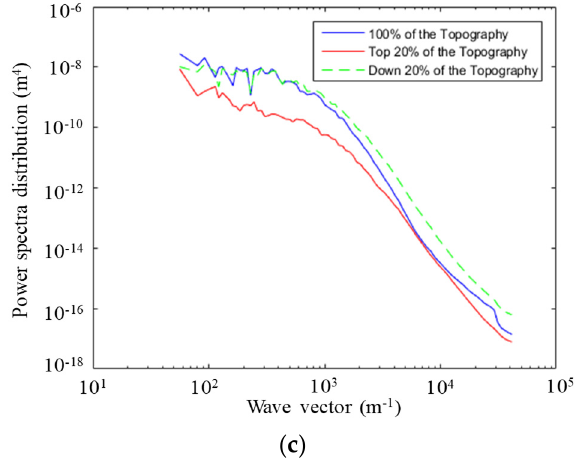
Figure 3. The 2D − PSD of asphalt pavement texture: ( a ) AC − 13 asphalt pavement; ( b ) SMA − 13 asphalt pavement; ( c ) OGFC − 13 asphalt pavement.